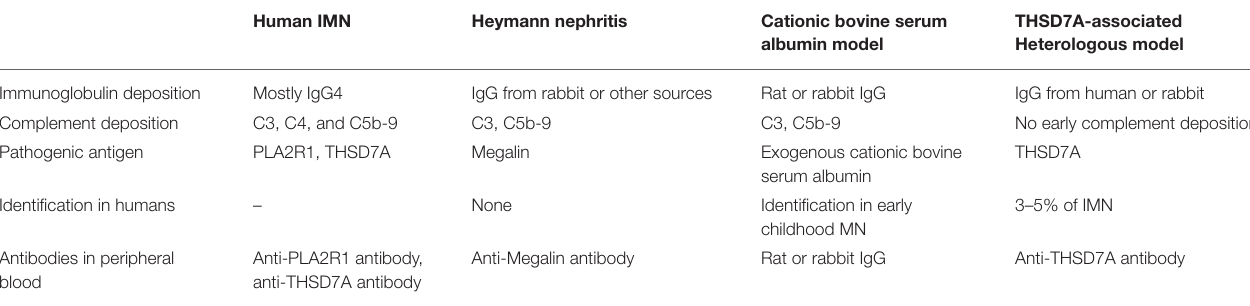
TABLE 2 | Morphological and serological connections between animal and human membranous nephropathy.